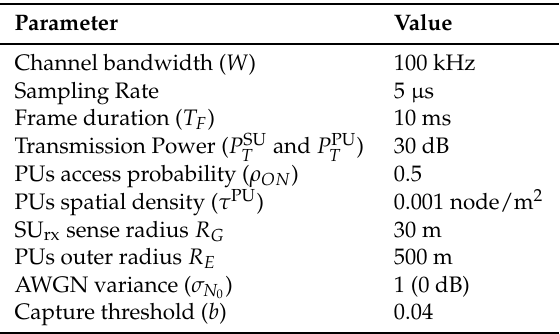
Table 1. Parameters used for performance evaluation of the SUs and PUs Wireless